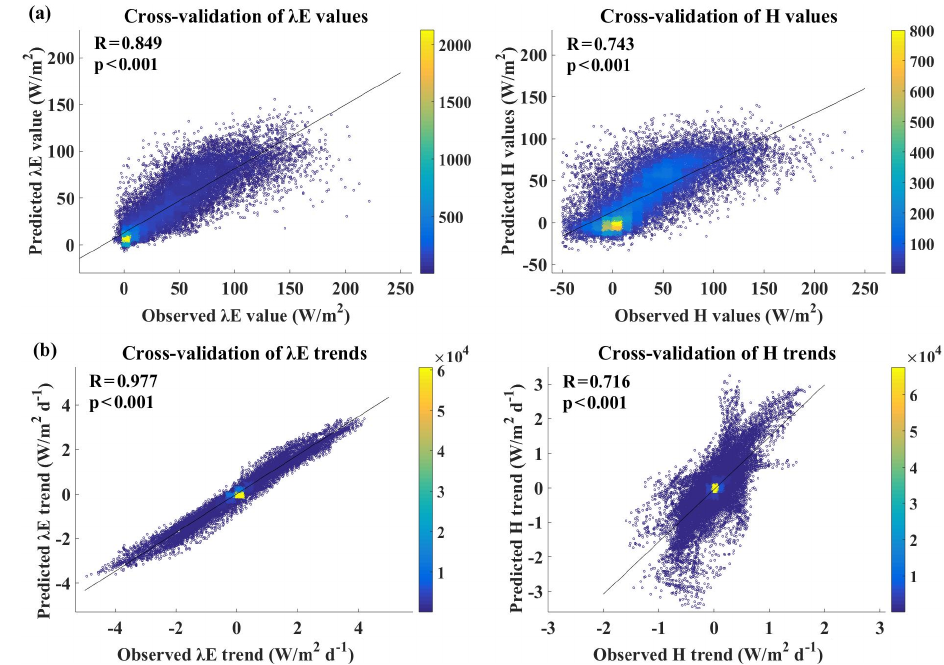
Figure 2. Density scatter plot for (a) the cross-validation in terms of values and (b) the cross-validation in terms of trends. The validation set of cross-validation values is composed of 10 flux towers randomly selected from different plant function types, and the validation set of trends cross-validation is composed of the trends calculated from all time periods of the availability of the flux tower observations. The trends are calculated using linear trend